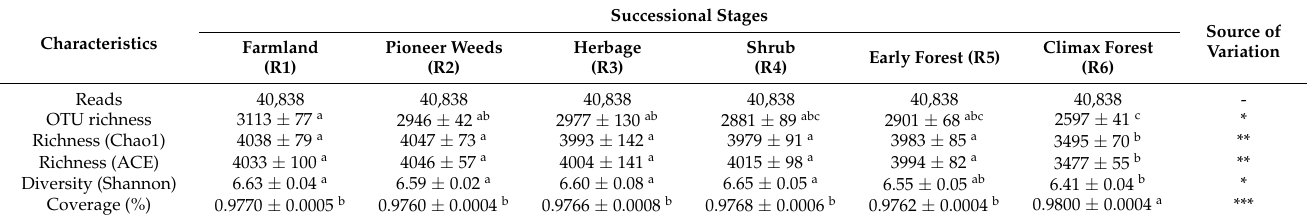
Table 1. Number of sequences analyzed and observed soil bacterial community richness and diversity indices (mean ± SE, n = 4) at different successional stages on the Loess Plateau of China, obtained for clustering at 97%